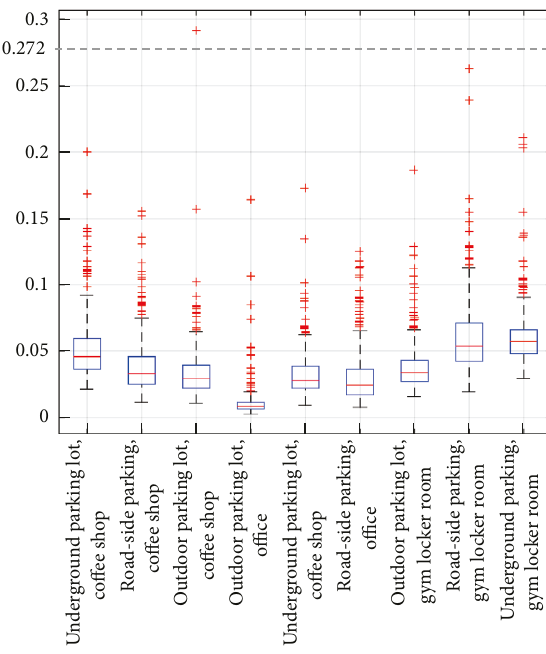
Figure 8: Impact of the sound-similarity scores on the paired